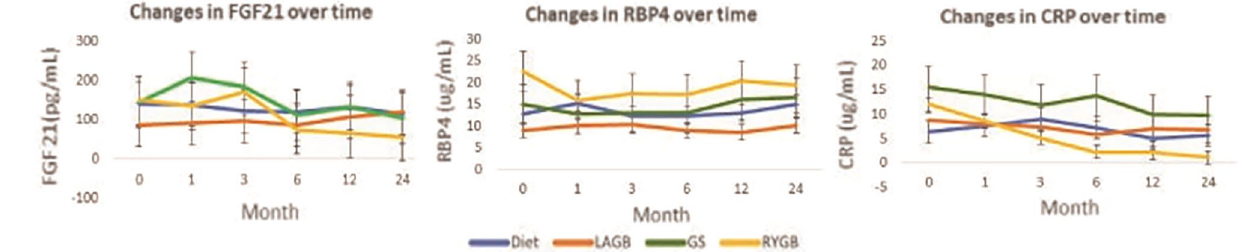
Figure 2. Changes in hormones FGF21, RBP4 and CRP following weight loss